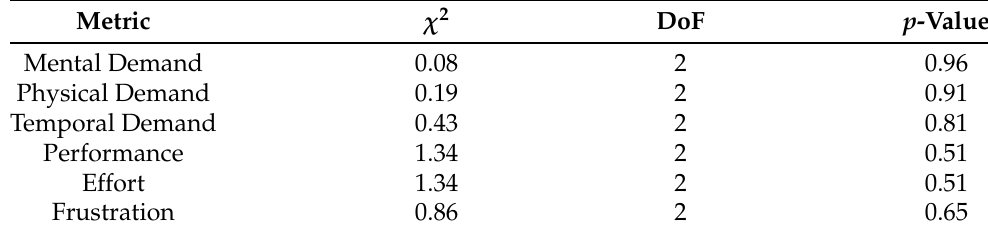
Table 5. Friedman’s test results for individual NASA TLX metrics.